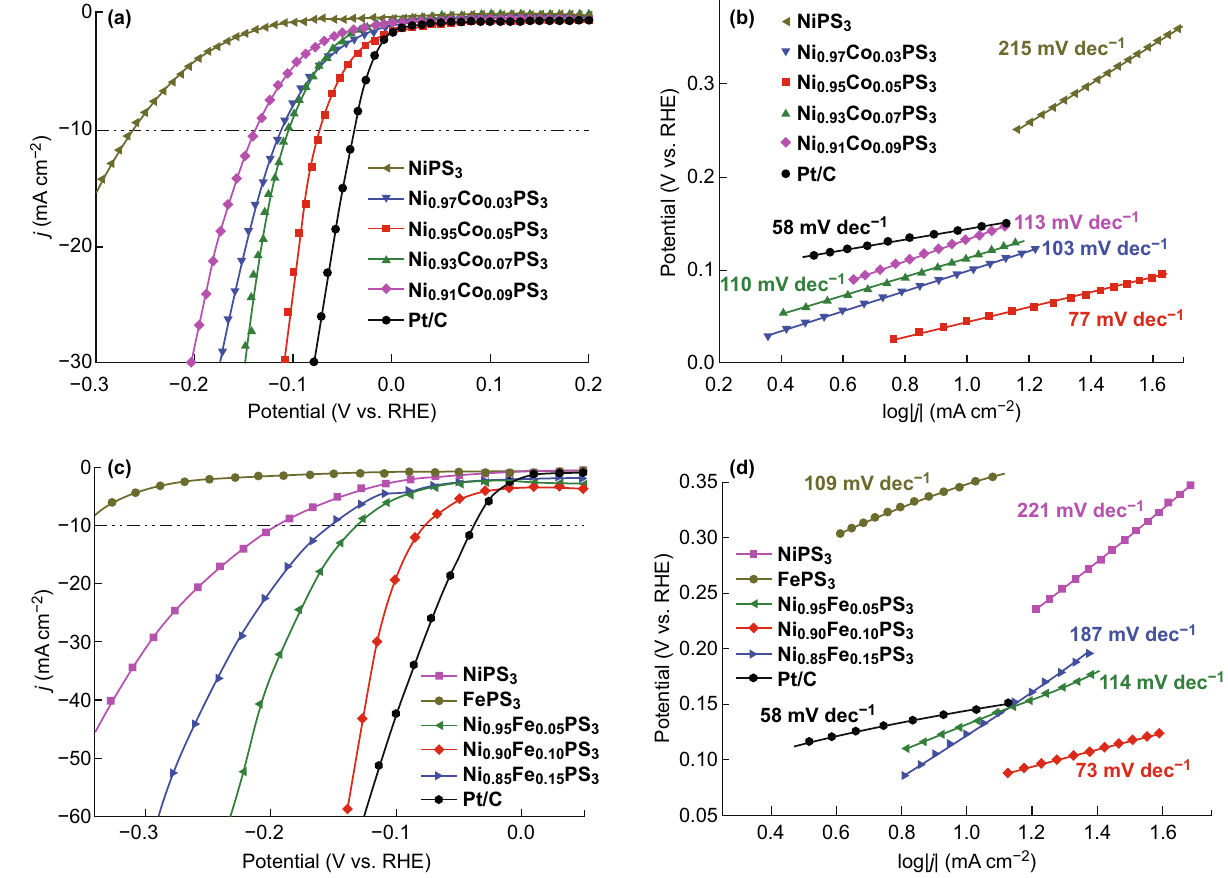
Fig. 5 Electrochemical properties of as-prepared Ni 1 - x Co x PS 3 and Ni 1 - x Fe x PS 3 nanosheets for the HER in 1 m KOH. a J – V curves after i R correction for application of NiPS 3 and various Ni 1 - x Co x PS 3 samples in the HER, in comparison with the commercial Pt/C catalyst; b Tafel plots for the data presented in a [72]. Reproduced with permission. Copyright (2017), Royal Society of Chemistry. c J – V curves after i R correction for application of FePS 3 , NiPS 3 , and various Ni 1 - x Fe x PS 3 samples in the HER, in comparison with 20 wt% Pt/C commercial catalyst; d Tafel plots for the data presented in c [73]. Reproduced with permission. Copyright (2017), American Chemical